Question: In a single sentence, describe what this figure presents.
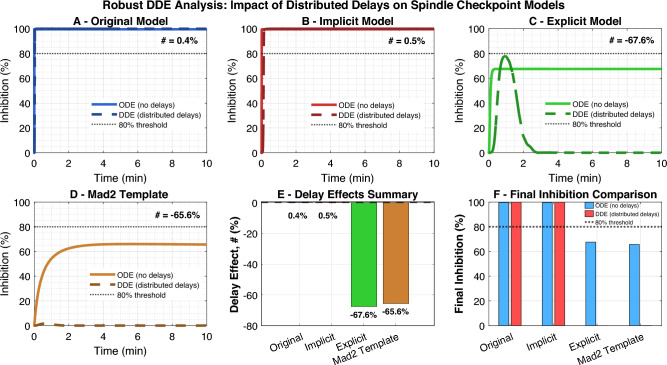
Answer: Distributed delays discriminate robust and fragile SAC architectures. (A–D) Time courses comparing ODE (solid) and distributed-delay (dashed) dynamics for the four canonical variants following kinetochore activation at \documentclass[12pt]{minimal} \usepackage{amsmath} \usepackage{wasysym} \usepackage{amsfonts} \usepackage{amssymb} \usepackage{amsbsy} \usepackage{mathrsfs} \usepackage{upgreek} \setlength{\oddsidemargin}{-69pt} \begin{document}$$t=0$$\end{document} . (E) Delay-induced change in steady-state inhibition ( \documentclass[12pt]{minimal} \usepackage{amsmath} \usepackage{wasysym} \usepackage{amsfonts} \usepackage{amssymb} \usepackage{amsbsy} \usepackage{mathrsfs} \usepackage{upgreek} \setlength{\oddsidemargin}{-69pt} \begin{document}$$\Delta$$\end{document} inhibition). (F) Final inhibition across architectures. Delay-robust models retain \documentclass[12pt]{minimal} \usepackage{amsmath} \usepackage{wasysym} \usepackage{amsfonts} \usepackage{amssymb} \usepackage{amsbsy} \usepackage{mathrsfs} \usepackage{upgreek} \setlength{\oddsidemargin}{-69pt} \begin{document}$$>\!80\%$$\end{document} inhibition, whereas delay-sensitive designs lose checkpoint function under the same physiological delays.